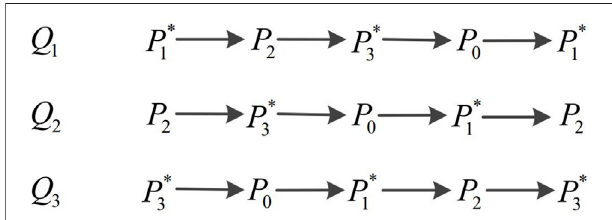
FIGURE 3 | Running process of the example, Q i represents the process in which the initiator is P i